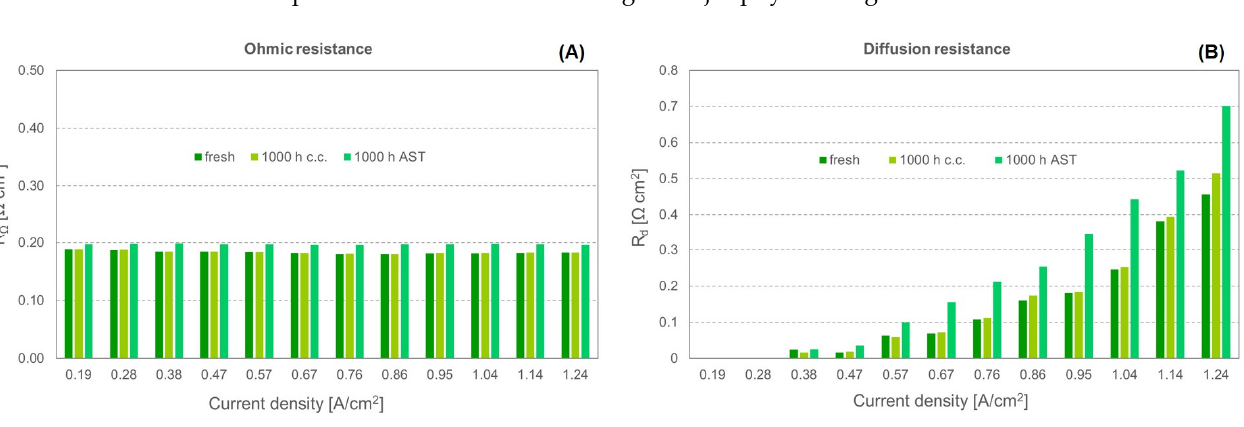
constant current tests and AST, compared with the fresh